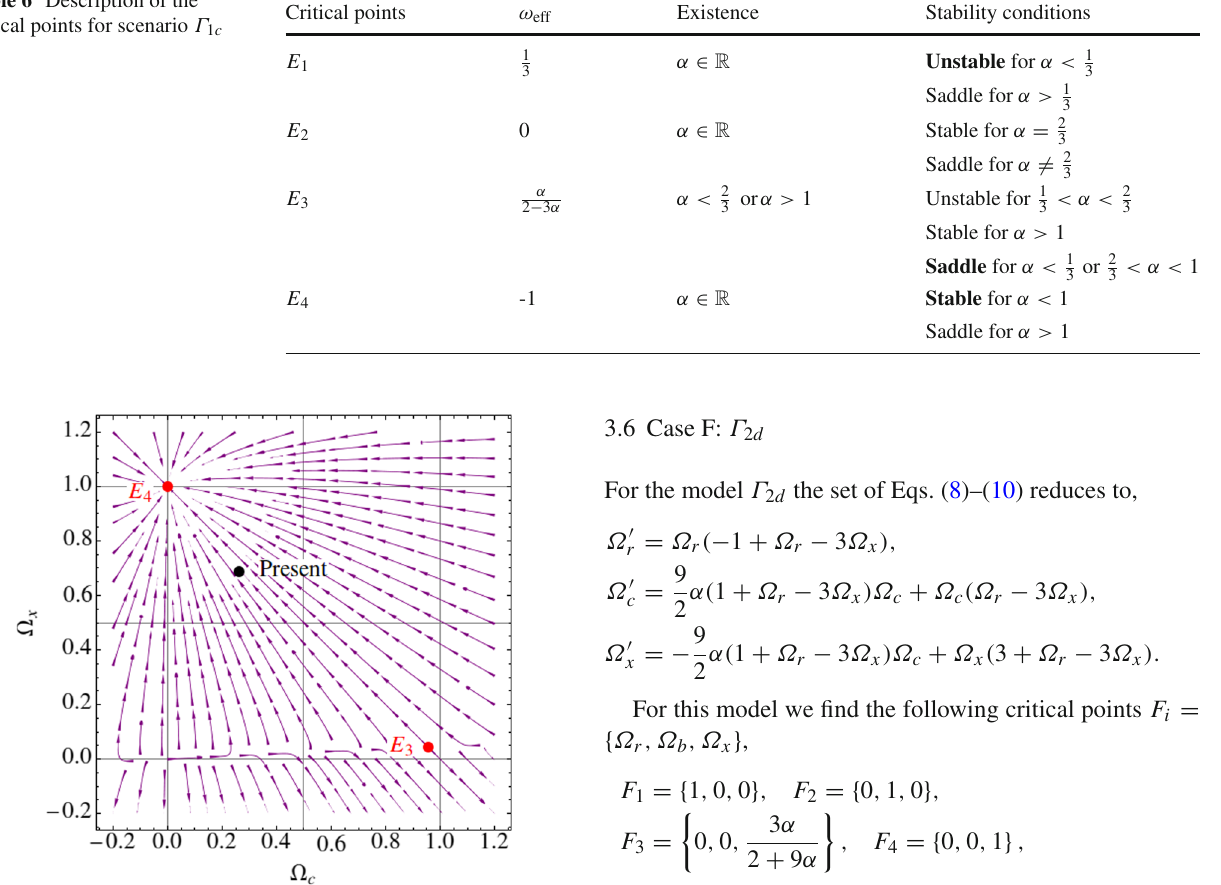
Fig. 5 Projected phase plot for model Γ 1 c with α = − 0 .